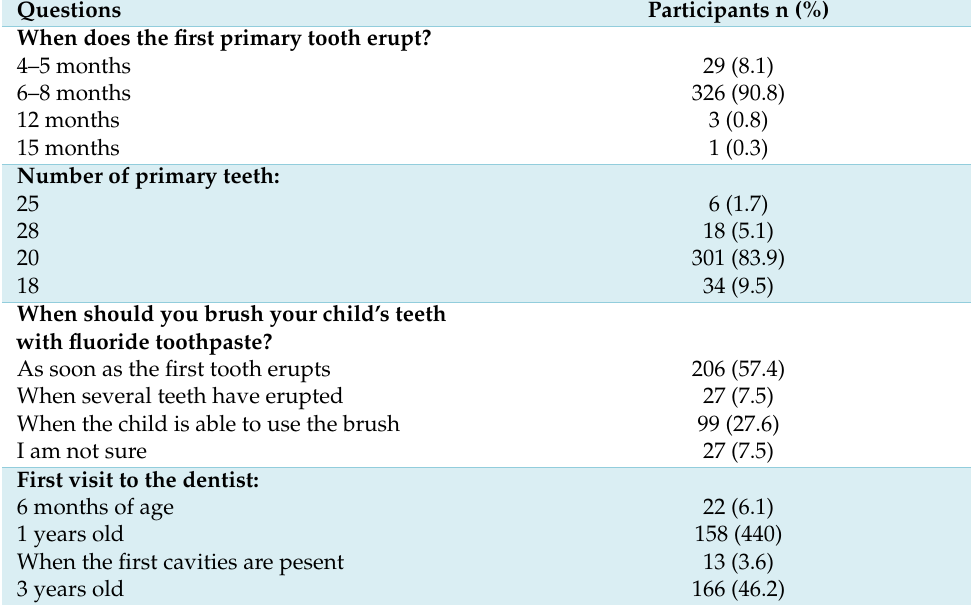
Table 2. Knowledge and attitudes about primary